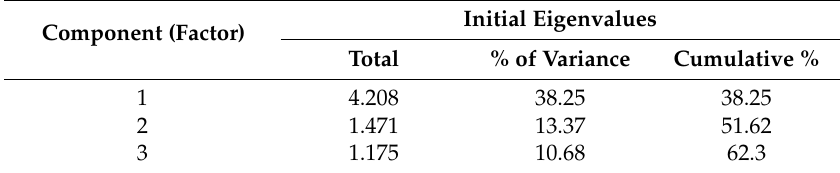
Table 5. Varimax rotated factor of PCA of Erren River water quality.